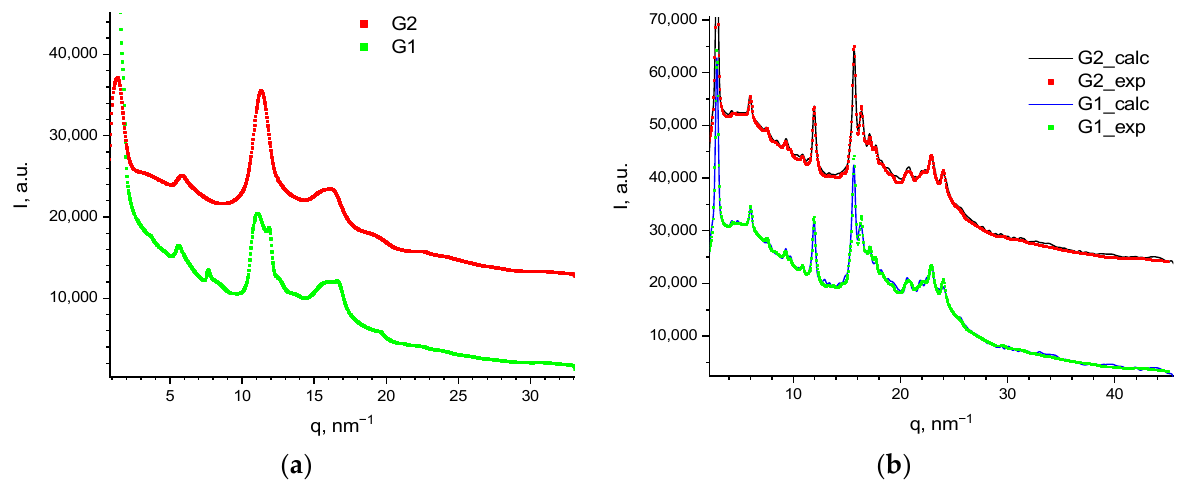
Figure 5. WAXS curves for G1 and G2, as-received ( a ), and annealed samples at 300 °C ( b ). Solid lines show the Pawley refinement, and dots are for the experimental data. Curves are shifted vertically for clarity.